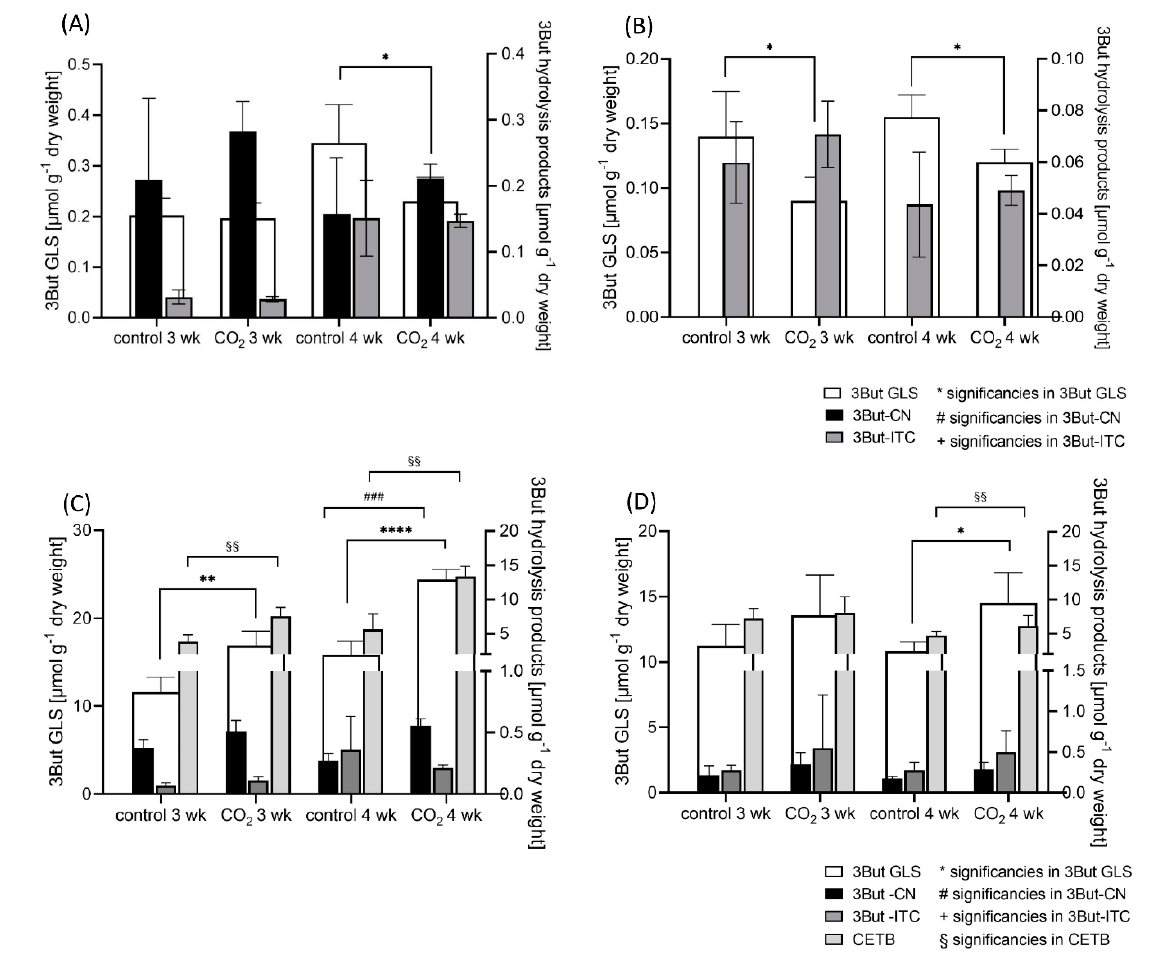
Fig. 5: Effect of elevated CO 2 on 3-butenyl glucosinolate (3But GLS) and the formation of its hydrolysis products from A. thaliana . Elevated (2%) [CO 2 ] effects on 3But GLS and formation of its hydrolysis products in accessions Hi-0 (A, B: experiment I and II) and Bur-0 (C, D: experiment I and II) were compared to ambient air (0.04% [CO 2 ]) (control). Averages and standard deviations of biological replicates (n = 4-5) are shown for two experimental replications (A, B and C, D) separately. Significant differences are marked with symbols (*, #, +, §; for example *, p < 0.05; **, p < 0.01; ***, p < 0.005; unpaired t Test). Abbreviations: 3But-CNs: 4-pentenenitrile, 3But-ITC: 3-butenyl isothiocyanate, CETB: